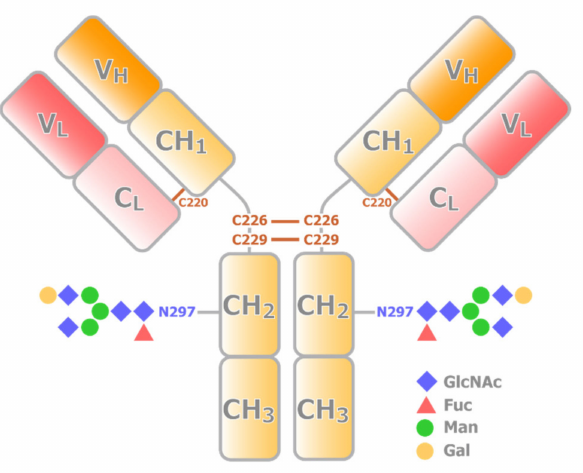
Figure 1. Schematic representation of the structure of IgG. An IgG consists of two heavy chains (yellow) and two light chains (red). The V H and CH 1 domains from a heavy chain interact with a light chain to form a Fab portion, while CH 2 and CH 3 domain dimer forms Fc portion. Fab and Fc portions are connected by the hinge region, where multiple conserved disulfide bridges are present. CH 2 domain has a conserved N-glycosylation